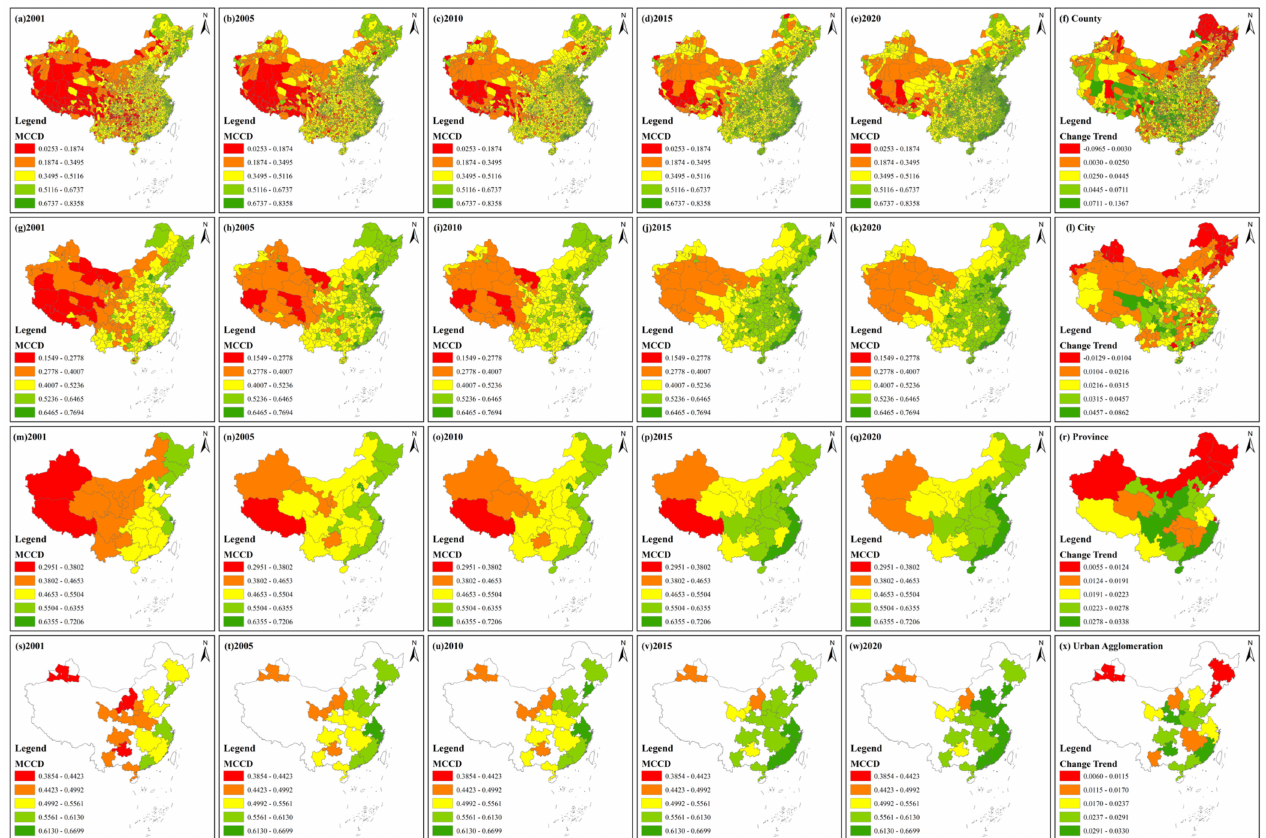
Figure 5. Spatial distribution and change trend of the MCCD from 2001 to 2020 at different scales. ( a – e ), ( g – k ), ( m – q ) and ( s – w ) display the spatial distribution of the MCCD at the county, city, province and urban agglomeration scales, respectively. ( f , l , r , x ) show the change trend of the MCCD at four